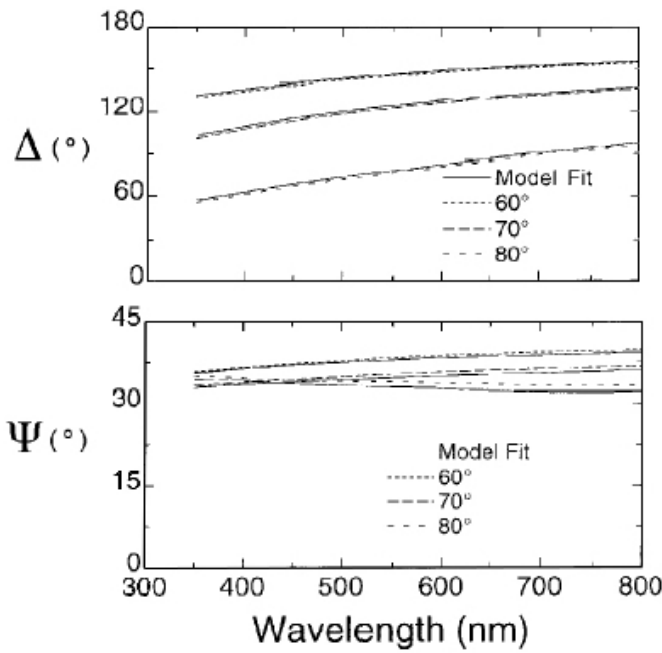
Figure 7. Full wavelength spectra were recorded for three incident angles of light upon platinum films deposited on silicon wafers. Applying the model fits to each spectrum determined that the film thickness was derived to be 65.3nm. (Reprinted from [58], Copyright John Wiley and Sons, Ltd.,